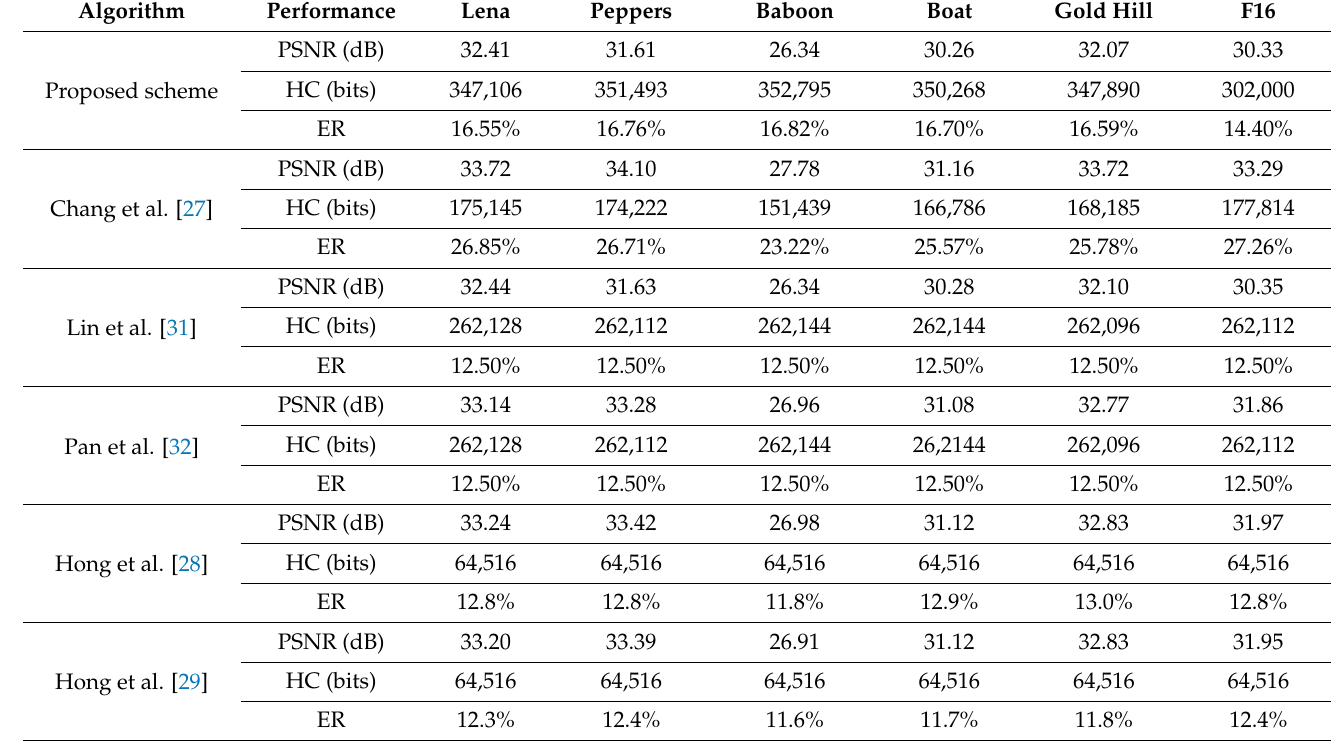
Table 6. Comparison of six